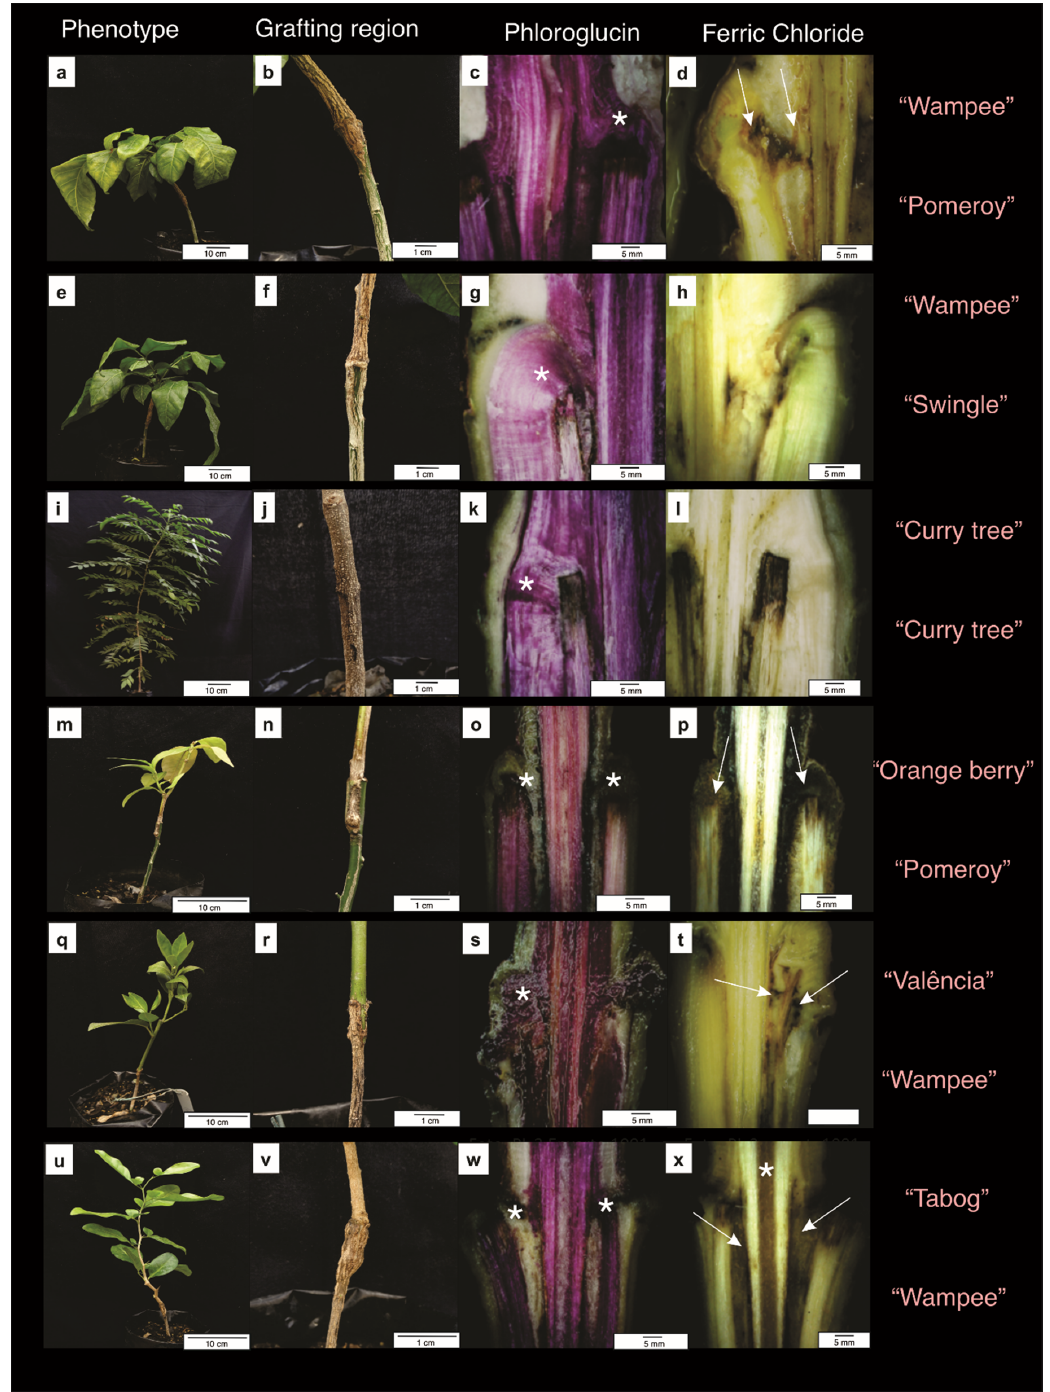
Figure 3. Six grafting combinations of Aurantioideae plants indicating the plant phenotype ( a , e , i , m , q , u ), and images of the graft union ( b , f , j , n , r , v ), phloroglucin reaction ( c , g , k , o , s , w ), and ferric chloride ( d , h , l , p , t , x ). Asterisks in ( c , g , k , o , s , w ): phloroglucin reaction in pink indicates lignified cell walls. Arrows in ( d , p , t , x ): ferric chloride indicates phenolic compounds in brown. Wampee/Pome- roy, Wampee/Swingle, and Curry tree/Curry tree have great vascular connection ( c , g , k ) and do pre- sent few spots with phenolic compounds ( d , h , l ). Orange berry/Pomeroy, Rangpur/Wampee, and Tabog/Wampee present a poor vascular connection and phenolic compounds at the graft region. The asterisks in ( x ) indicate phenolic compounds in the pith region of the scion.